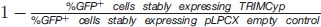
The association between the monomer to multimer ratio and anti-HIV-1 activity.The left y-axis indicates the ratio of monomer to multimers of the indicated TRIMCyp proteins in 0.25 mM glutaraldehyde, which was calculated from the density of monomer, dimer and trimer (Fig. 2B, 3B and 4C) using ImageJ software. The right y-axis indicates the viral restriction abilities of the indicated TRIMCyp proteins (in Fig. 3A and 4A), which was calculated using the formula: 1−%GFP+ cells stably expressing TRIMCyp%GFP+ cells stably expressing pLPCX empty control. The error bar represents the SEM.